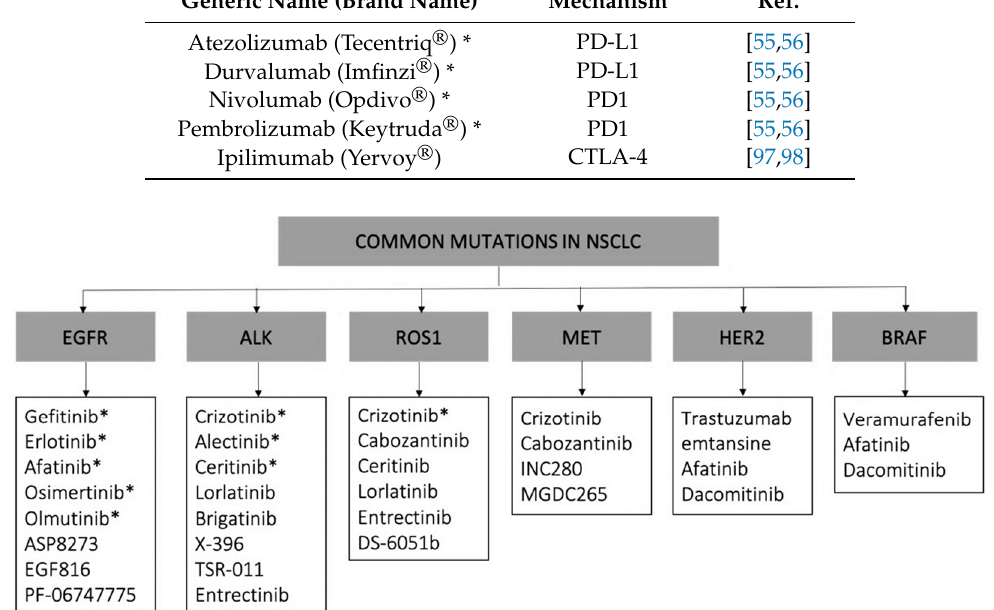
Figure 4. Available molecular targeted drugs for NSCLC [87]. * FDA-approved drugs for NSCLC. Most TKIs are administered orally, which considerably complicates reaching the desired target.